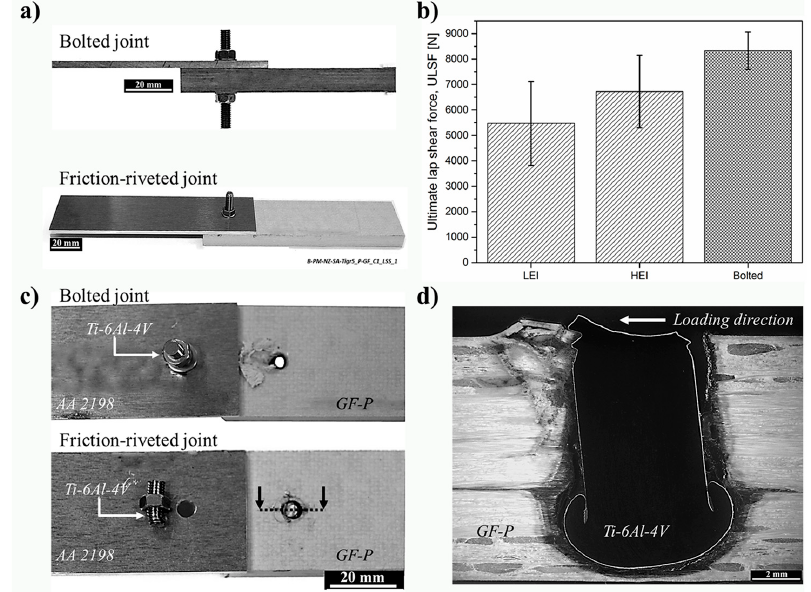
Figure 7. ( a ) Overview of an overlap Ti-6Al-4V/GF-P friction-riveted and bolted joints; ( b ) average ultimate lap-shear forces of friction-riveted joints produced under low (LEI) and high (HEI) energy inputs and state-of-the-art bolted joints; ( c ) example of fracture surfaces of a HEI friction-riveted and bolted joints; ( d ) cross-section of fractured friction-riveted joint from ( c ), showing the loading direction.